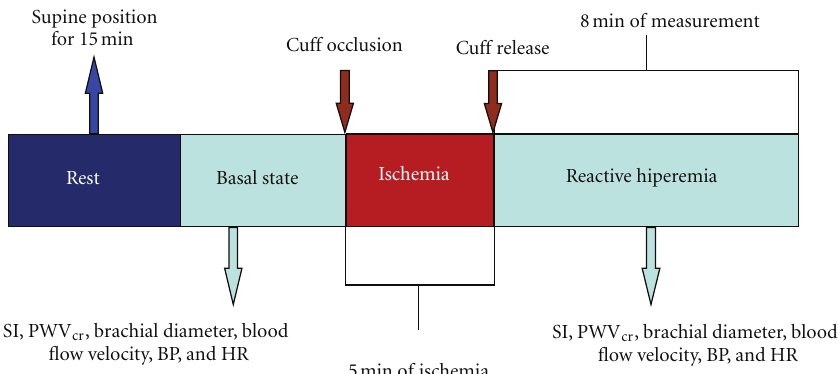
Figure 2: Representative diagram of the study protocol applied to evaluate changes in arterial biomechanics by means of PWA (sti ff ness index) and PWV.